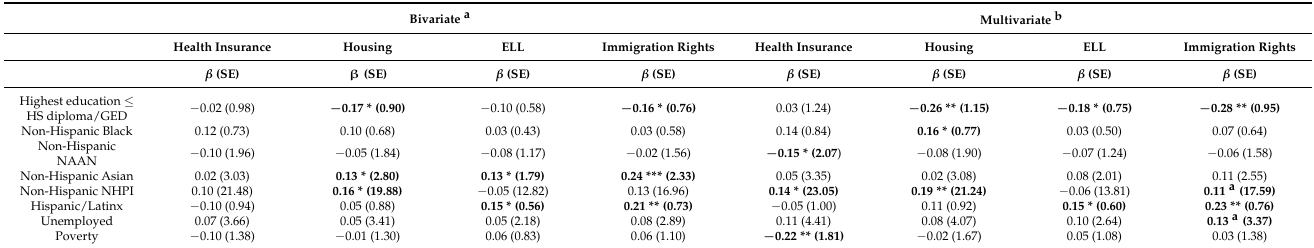
Table 4. Results of Multivariate Linear Regressions of the Relationship between Census Tract Demo- graphics and Social Programs Offered at Libraries in Census Tracts.